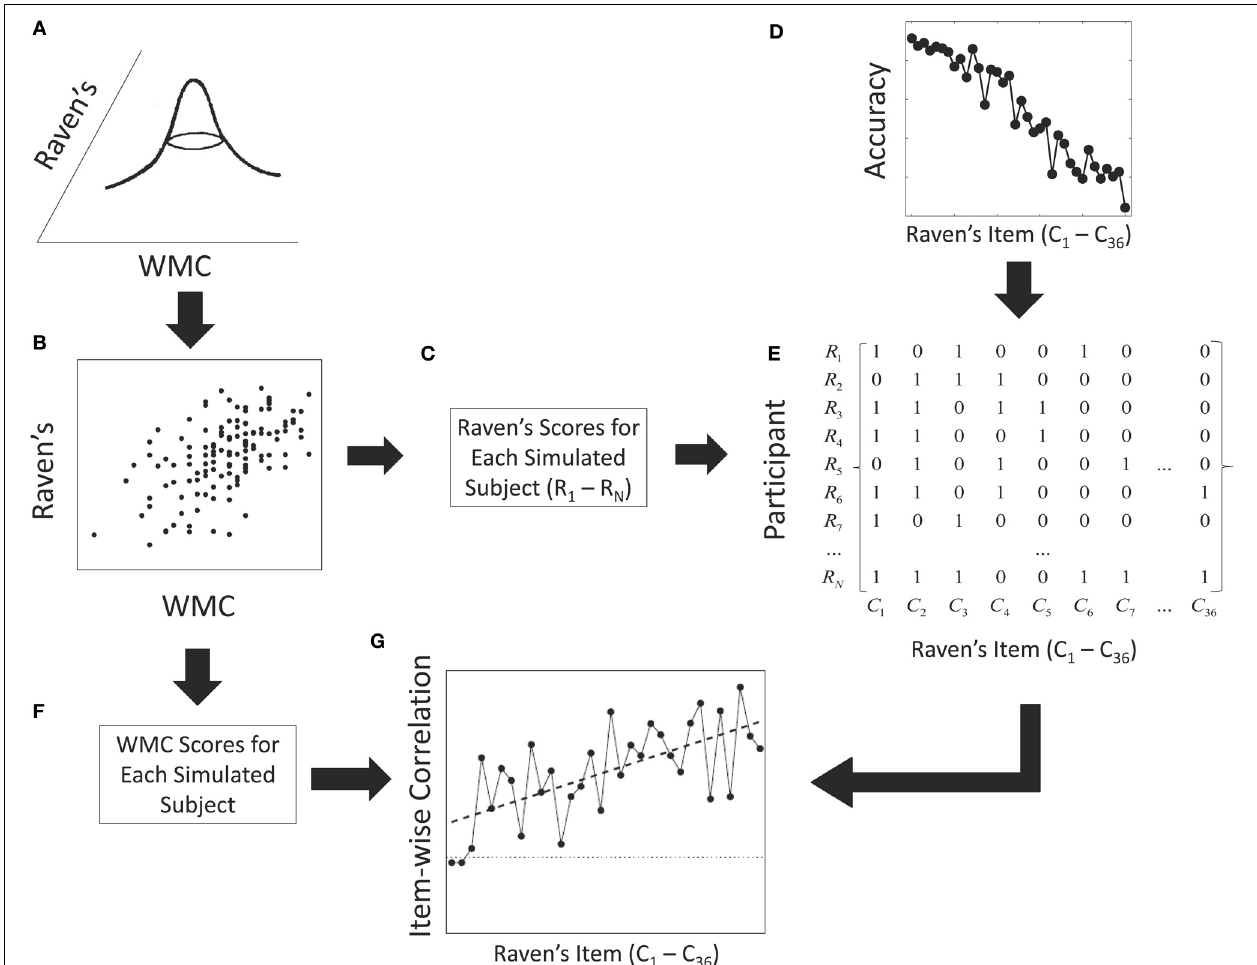
FIGURE 3 | Data generation process used in the simulation study. First, a pair of individual WMC and Raven’s scores are sampled from a bivariate normal distribution (A) . The sample shown in panel (B) is from the current behavioral study. The Raven’s scores for each simulated subject (C) and the accuracy on each Raven’s item (D) are used to